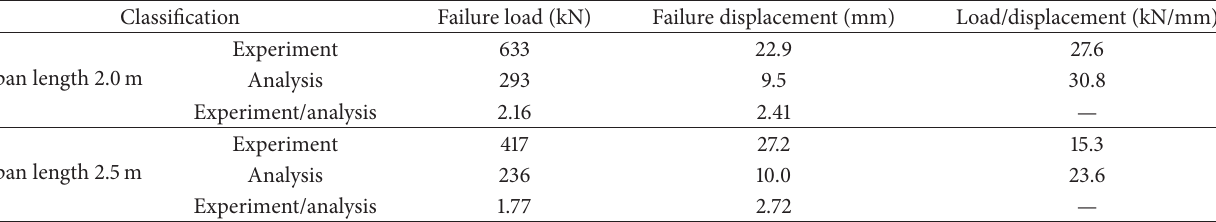
Table 3: Fracture tests and analysis results for 2.0 m and 2.5 m span